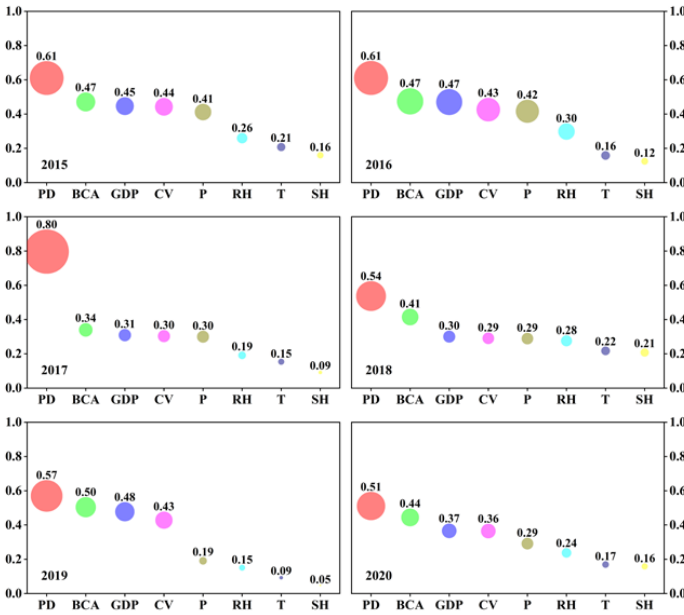
Figure 10. Variation characteristics of AQI driving force in Yunnan from 2015 to 2020 (RH: relative humidity; SH: sunshine hours; P: precipitation; T: temperature; PD: population density; BCA: building construction area; GDP: gross domestic product; CV: civilian vehicle).